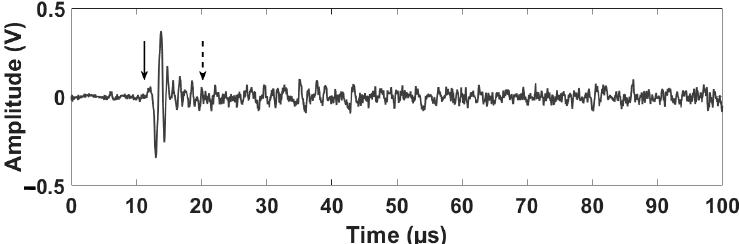
Figure 4. An example of the resulting laser-generated ultrasonic wave experimentally measured over the defective aluminum specimen. The solid arrow indicates the time of the direct laser-induced ultrasonic wave arrival (detected visually), while the dotted arrow indicates the estimated time instant of the ultrasonic defect-reflected echo arrival (detected theoretically). The absolute coordinates corresponding to the laser scan point are x = 11 mm and y = 51 mm, while the absolute coordinates corresponding to the ultrasonic transducer are x = 15 mm and y = 110 mm.